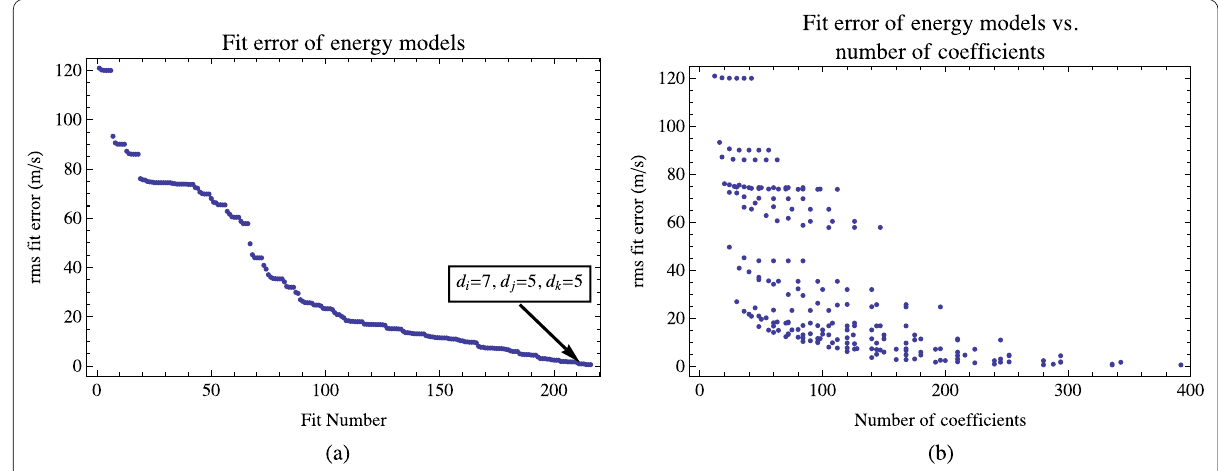
Fig. 25 RMS fit error for the level 1b energy transfer function for models with degree up to 7 in r , 5 in y 2 , and 5 in (cid:31) : (a) in order of decreasing rms error, and (b) in order of the number of coefficients in each